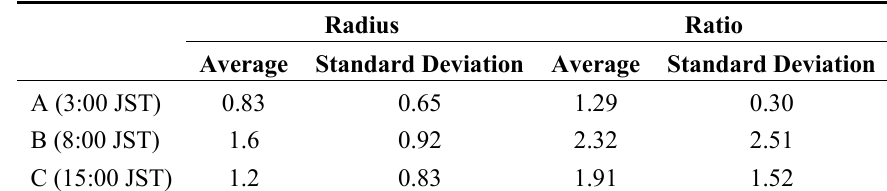
Table 1. Average and standard deviation of particle sizes and ratios of the major and minor axis. A (3:00 JST), B (8:00 JST) and C (15:00 JST) on 21 March 2010. Japan standard time (JST) is universal time (UT) +